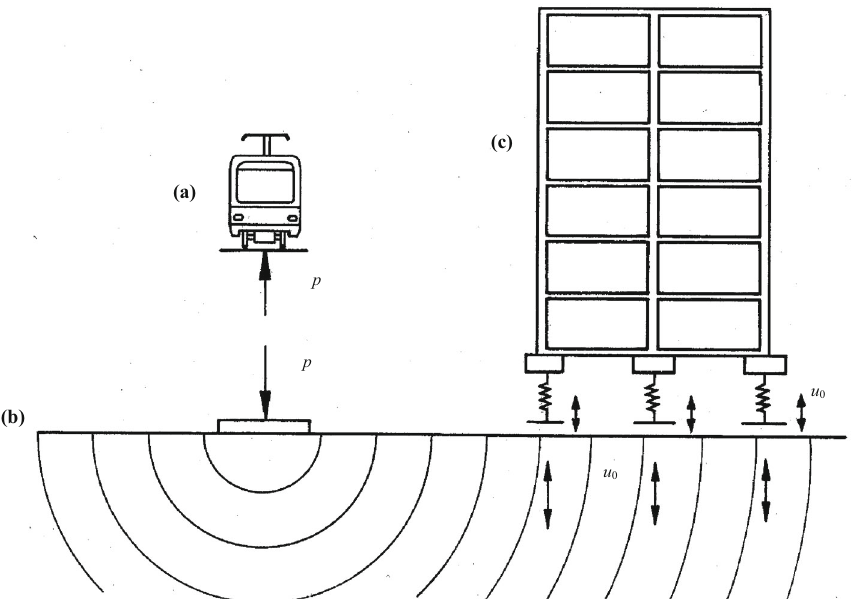
Fig. 1 The prediction of railway-induced vibration and its part a emission from the train, b transmission through the soil, and c immission into the